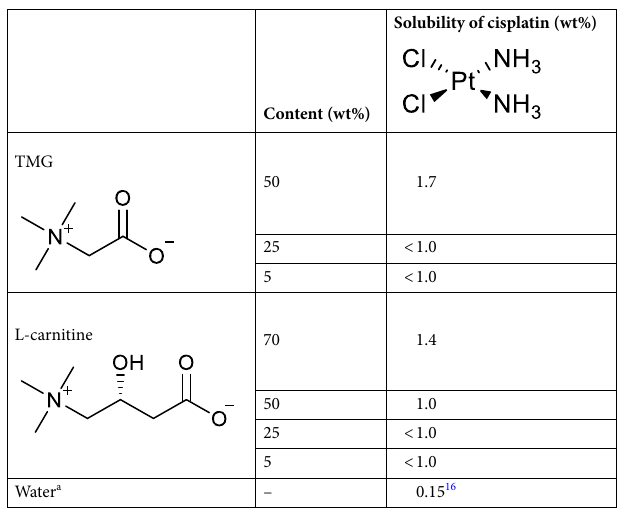
Table 1. Solubility of cisplatin in TMG or L-carnitine aqs. a 150 mM NaCl aq. at ambient temperature. The same solubility is shown in phosphate-buffered